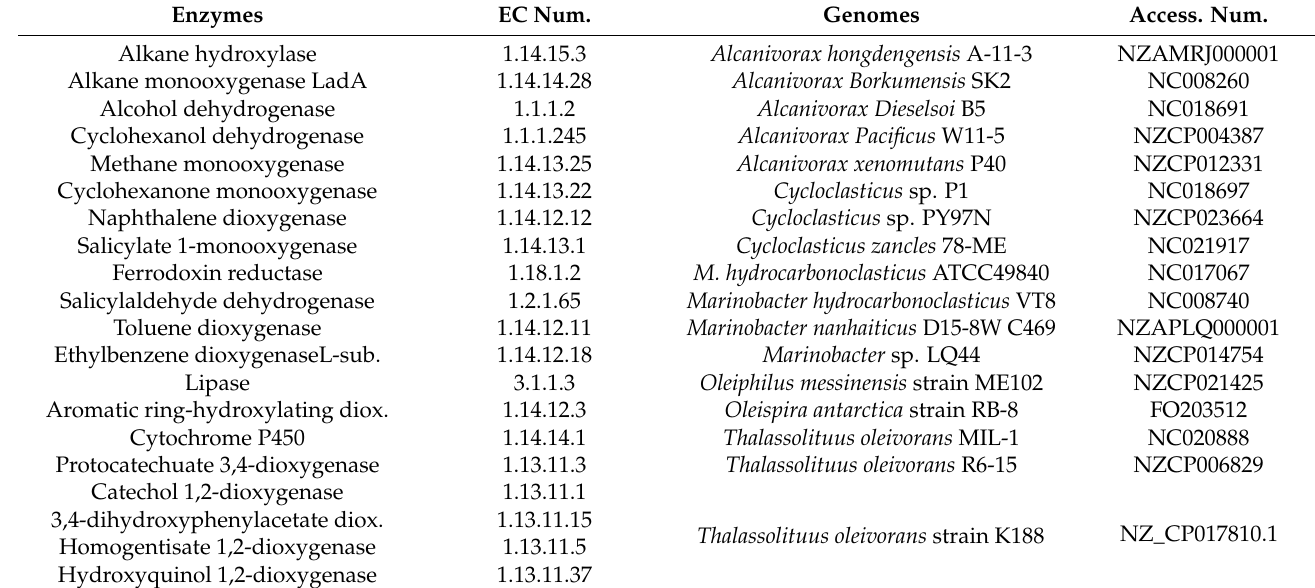
Table 4. List of enzyme and genomes used for sequence alignment. Only 100% complete genomes that are publicly available in NCBI database were included in the search. Enzymes EC Num. Genomes Access.